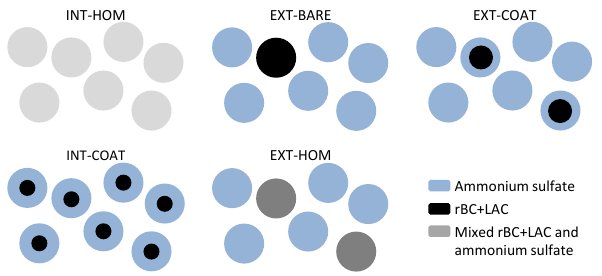
Figure 7. Illustration of the particle compositions for the five mix- ing state representations.